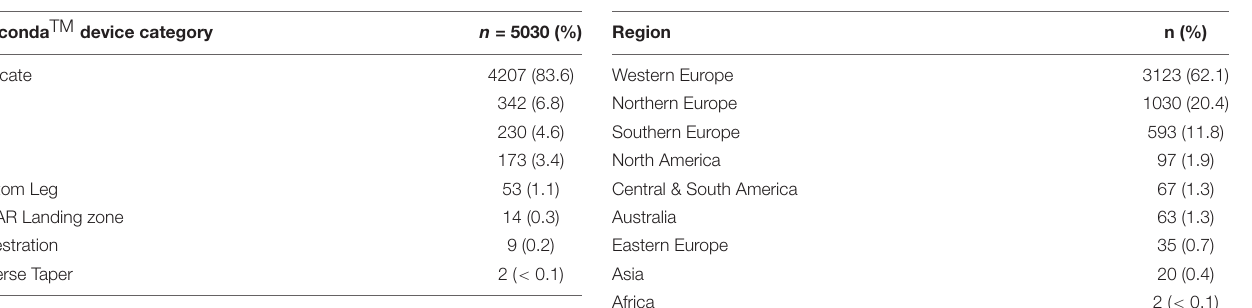
TABLE 1 | Summary of AnacondaTM device categories. TABLE 2 | AnacondaTM per geographical region.